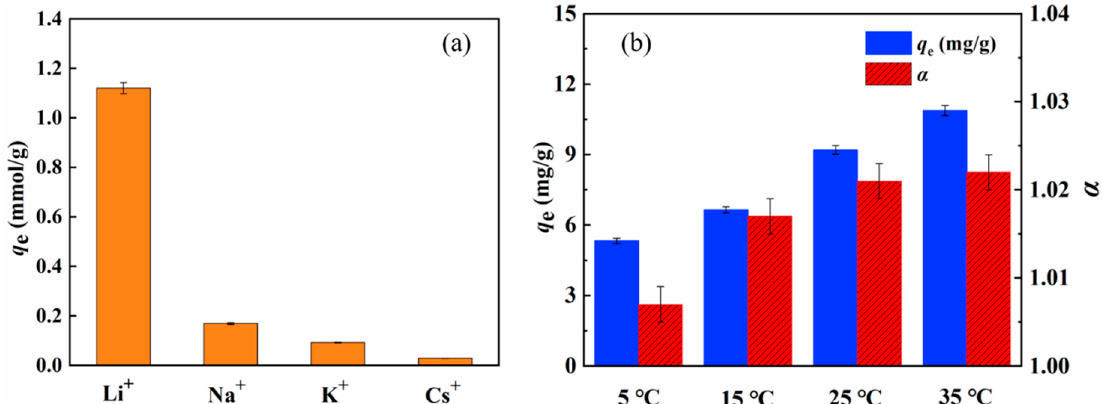
Figure 9. Selective adsorption ( a ) and effect of adsorption temperature ( b ) on the adsorption of Li + and separation factor of isotopes by MCM- g -AB15C5.